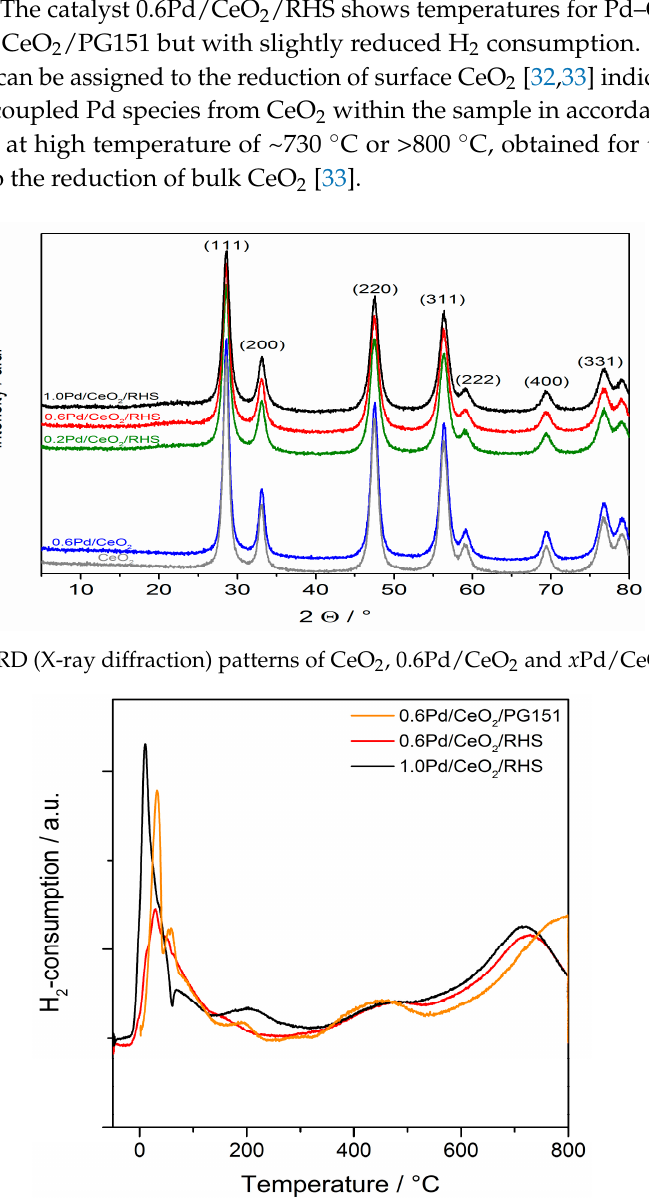
Figure 4. H 2 -TPR of 0.6/CeO 2 /RHS, 1.0Pd/CeO 2 /RHS, and 0.6Pd/CeO 2 /PG151.